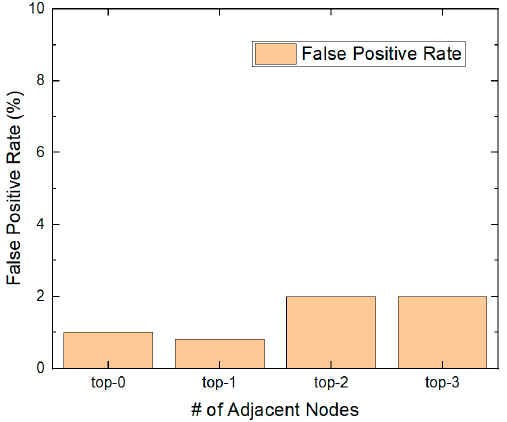
Figure 8. False Positive Rate according to the number of adjacent nodes.